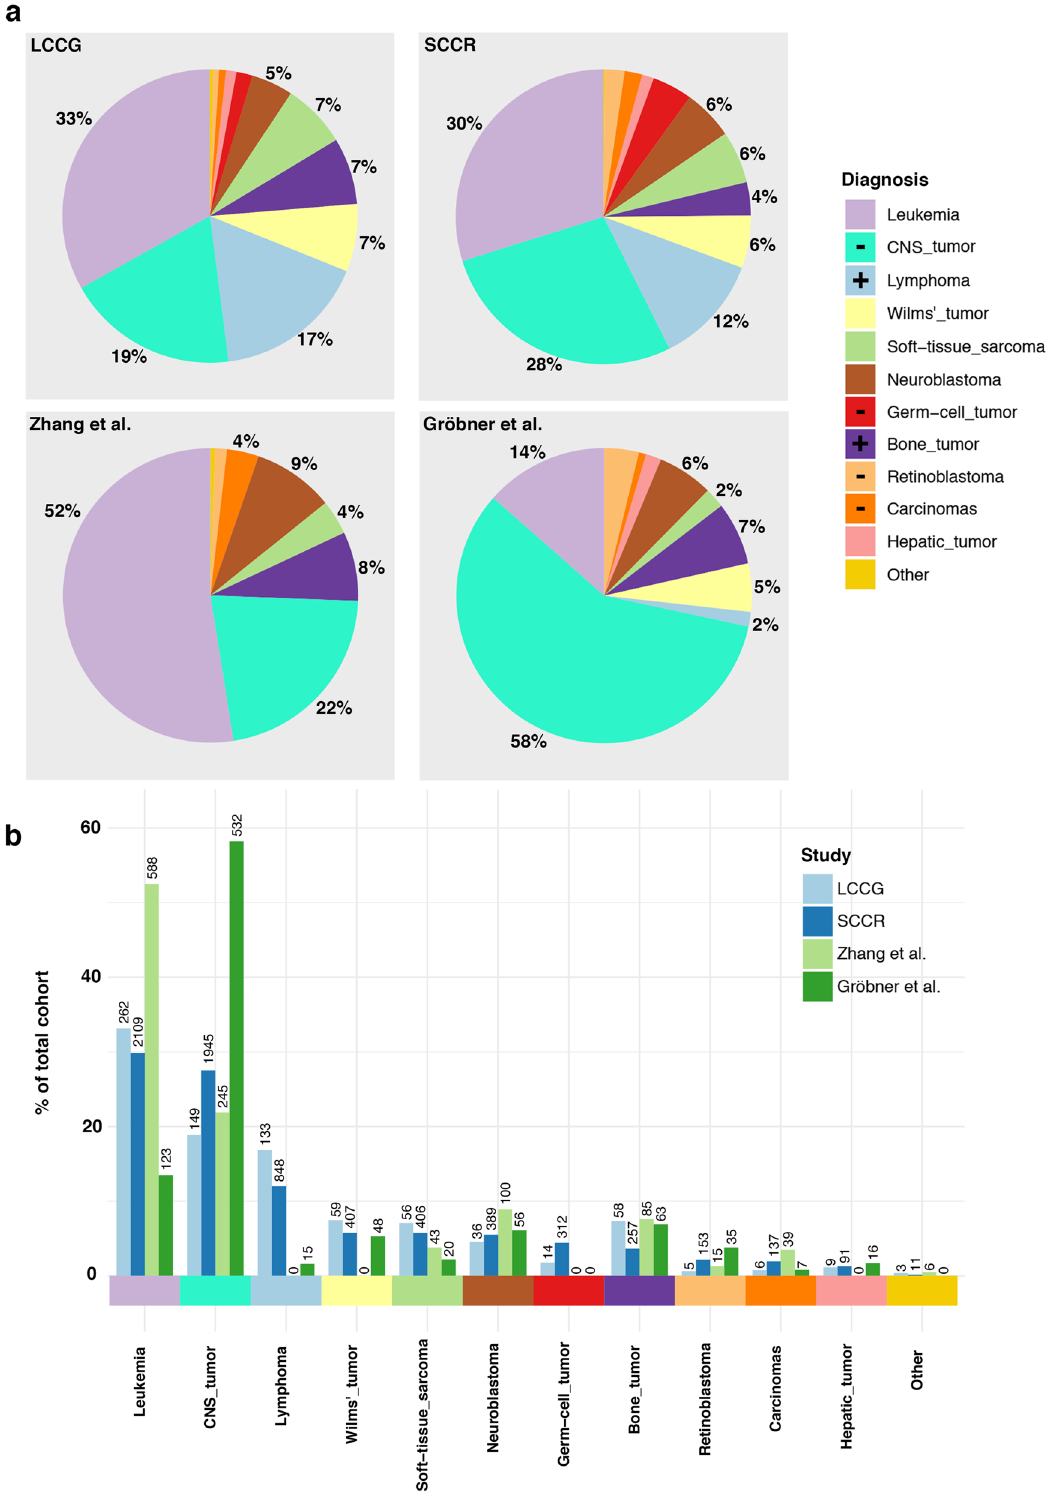
Figure 1. Pediatric cancer diagnosis distributions. ( a ) Distributions of the current LCCG cohort (n = 790; top left), the SCCR cohort (n = 7065; top right), the Zhang cohort (n = 1120; bottom left) and the Gröbner cohort (n = 914; bottom right). + and − indicate significant over- or under-representation of diagnoses in the LCCG cohort compared to the Swedish Childhood Cancer Registry (SCCR) cohort. Diagnosis percentage of each cohort for the largest diagnoses are displayed on each respective pie chart. ( b ) Distribution bar-plot of all cohorts divided according to diagnosis. Number of patients in each cohort diagnosis group is displayed above each bar. Comparative statistics (Fisher’s Exact test) are provided in Supplementary Table